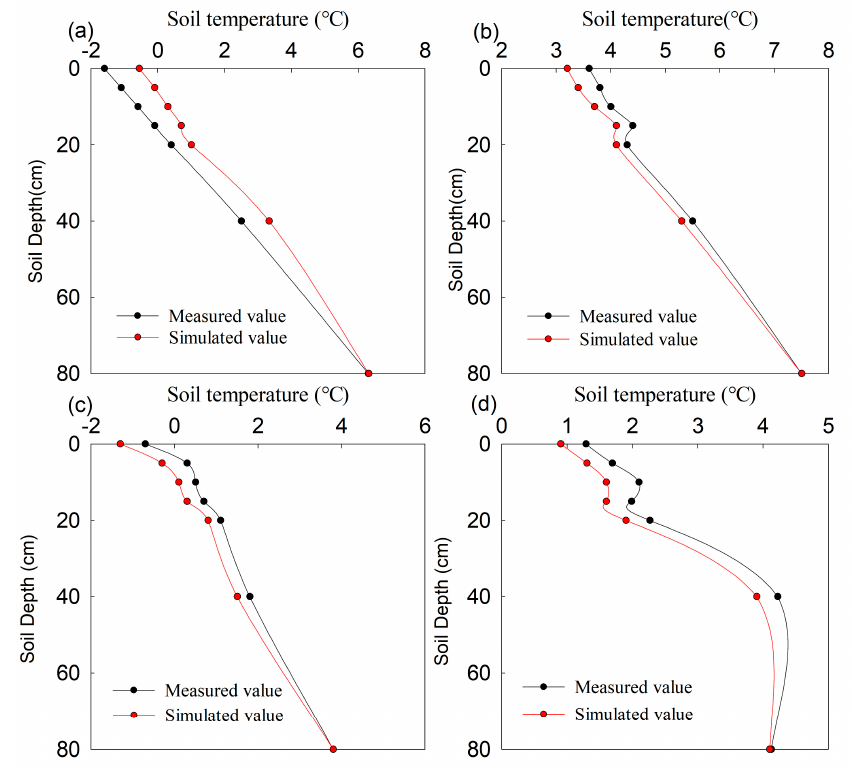
Figure 5. Comparison between the measured and simulated values of soil temperature when ( a ) the straw mulch thickness (SMT) was 5 cm on 11 December 2005, ( b ) the SMT was 15 cm on 11 December 2005, ( c ) the SMT was 10 cm on 21 January 2006, and ( d ) the SMT was 15 cm on 21 January 2006. ◦ The RMSE between simulated and measured soil temperature is 1.07–2.00 C, while that of soil − 3 water content is 0.003–0.08 m 3 · m . The results suggest a good match between simulated value and measured value, and the rationality of model